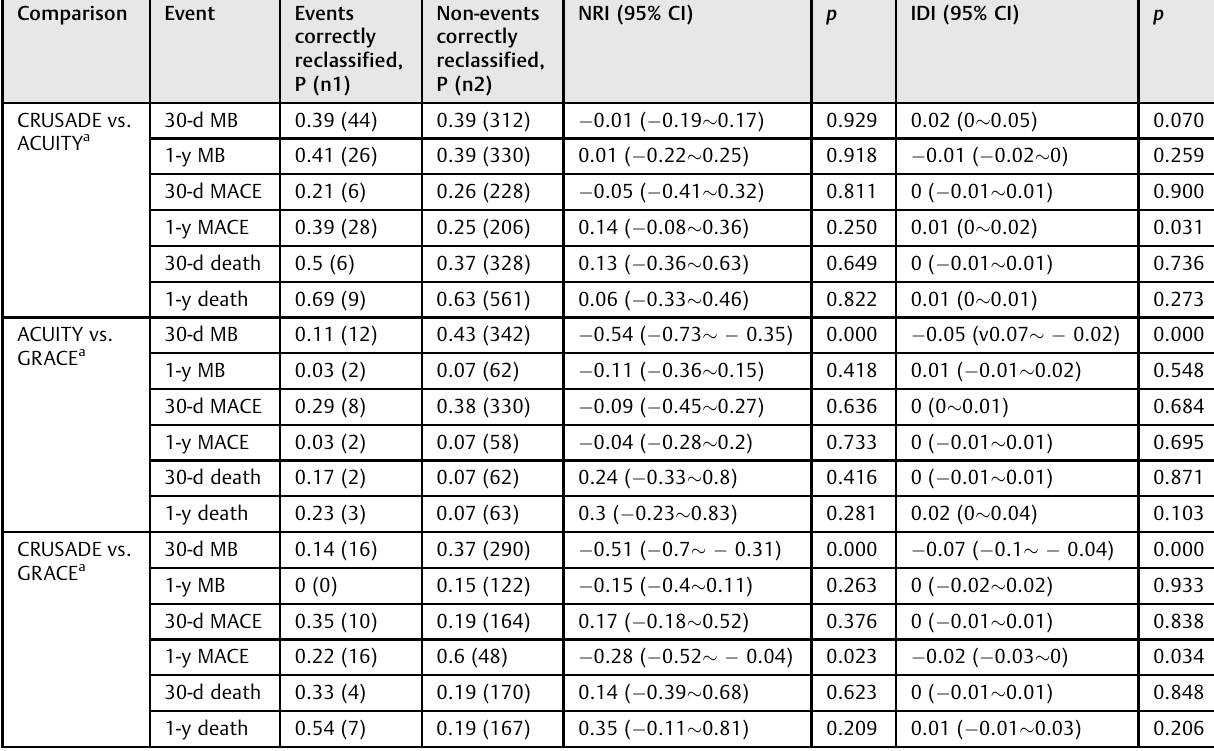
Table 4 Risk reclassi fi cation and integrated discriminatory improvement for outcomes